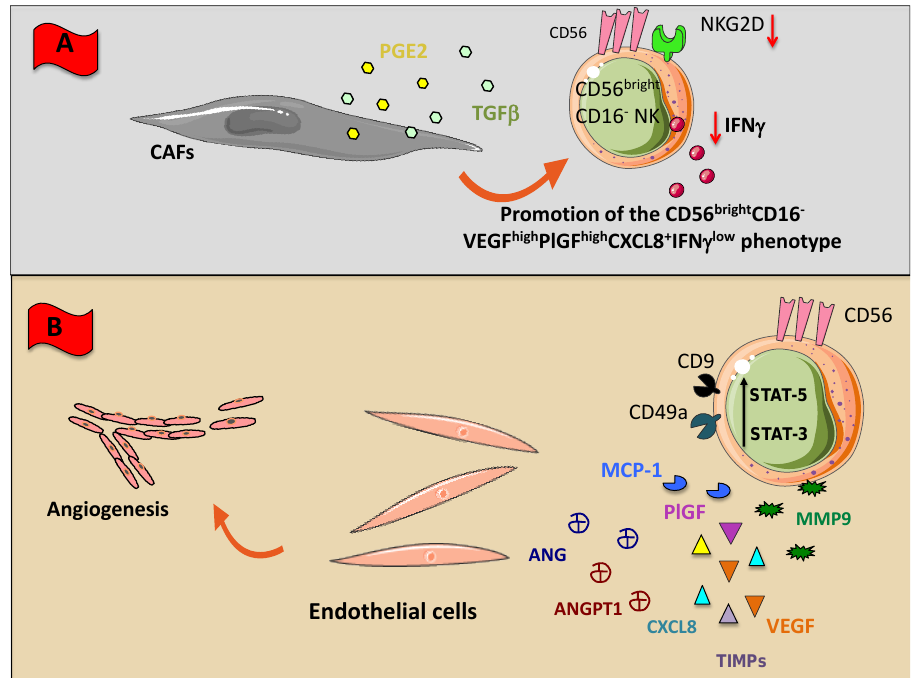
Figure 3. NK cross-talk with stromal (non-immune) cellular components of TME. Within TME, NK cells can encounter different non-immunological stromal cells such as macrophages ( A ), cancer associated fibroblasts (CAFs), and endothelial cells ( B ). All these cells have been shaped by the TME to exert an inhibitory effect on NK cells through the direct cell-to cell interaction or the soluble factors listed in Figure 1. ( A ) CAFs downregulate NK cell functions releasing inhibiting factors including TGF- β , and PGE 2 ; ( B ) Tumor infiltrating NK cells and NK cells present in peripheral blood express high levels of CD56 but negative or low expressing CD16 and cytolytic behavior; these NK cells typical of tumor patients produce several factors such as VEGF, Angiogenin (ANG), Angiopoietin-1 (ANGPT1), PIGF, CXCL8, and metalloproteinase which stimulate endothelial cell growth and